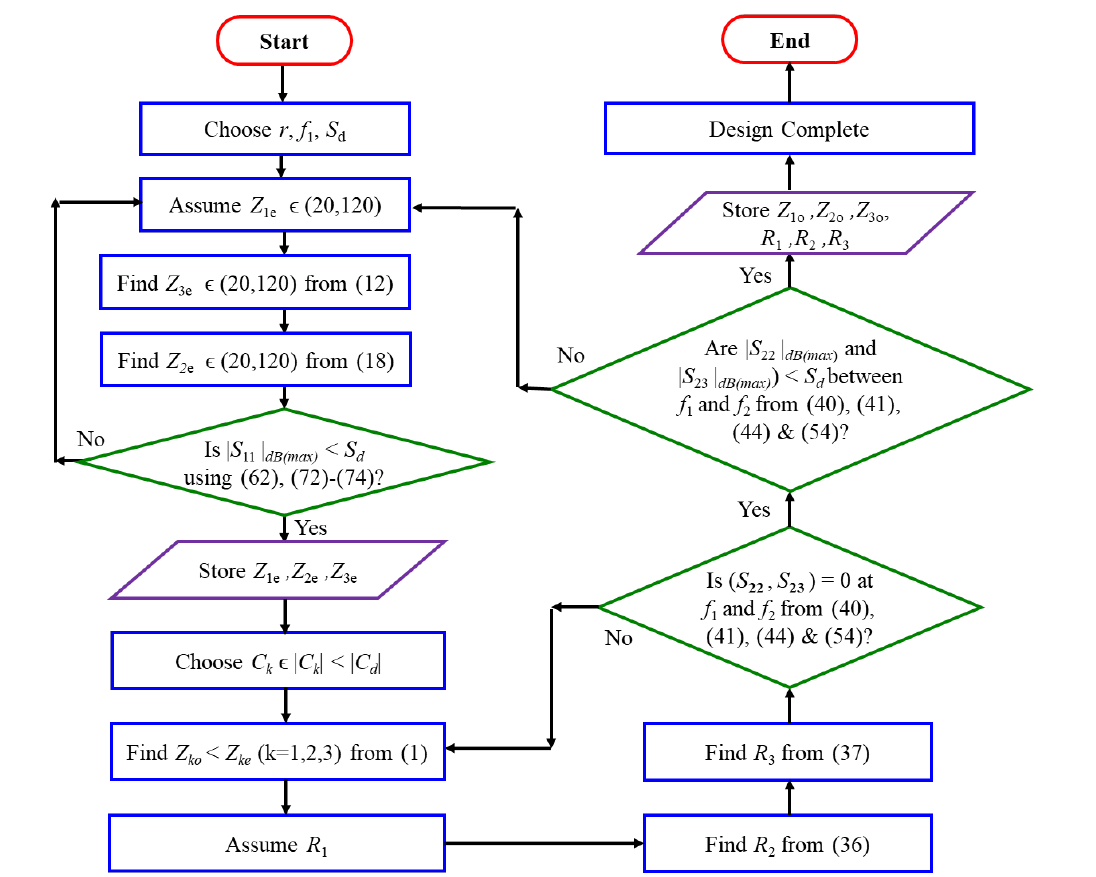
Figure 7. Flowchart of design steps. Table 2. Circuit Parameters with the variation of r